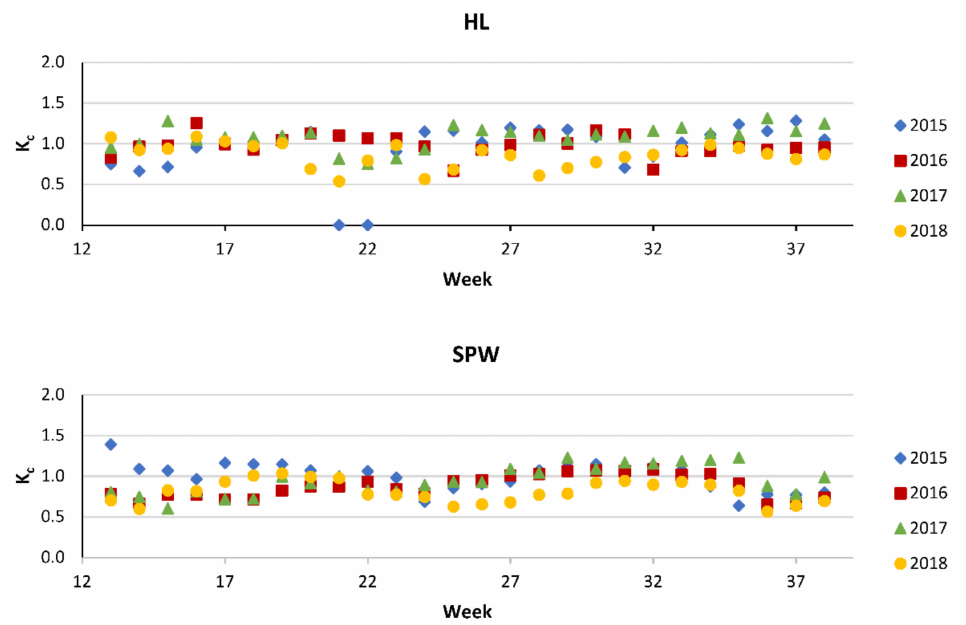
Figure 5. Weekly values of the crop coefficient K c in Havelländisches Luch (HL) and Spreewald (SPW) in the vegetation periods from 2015 to 2018 (Week—week of the